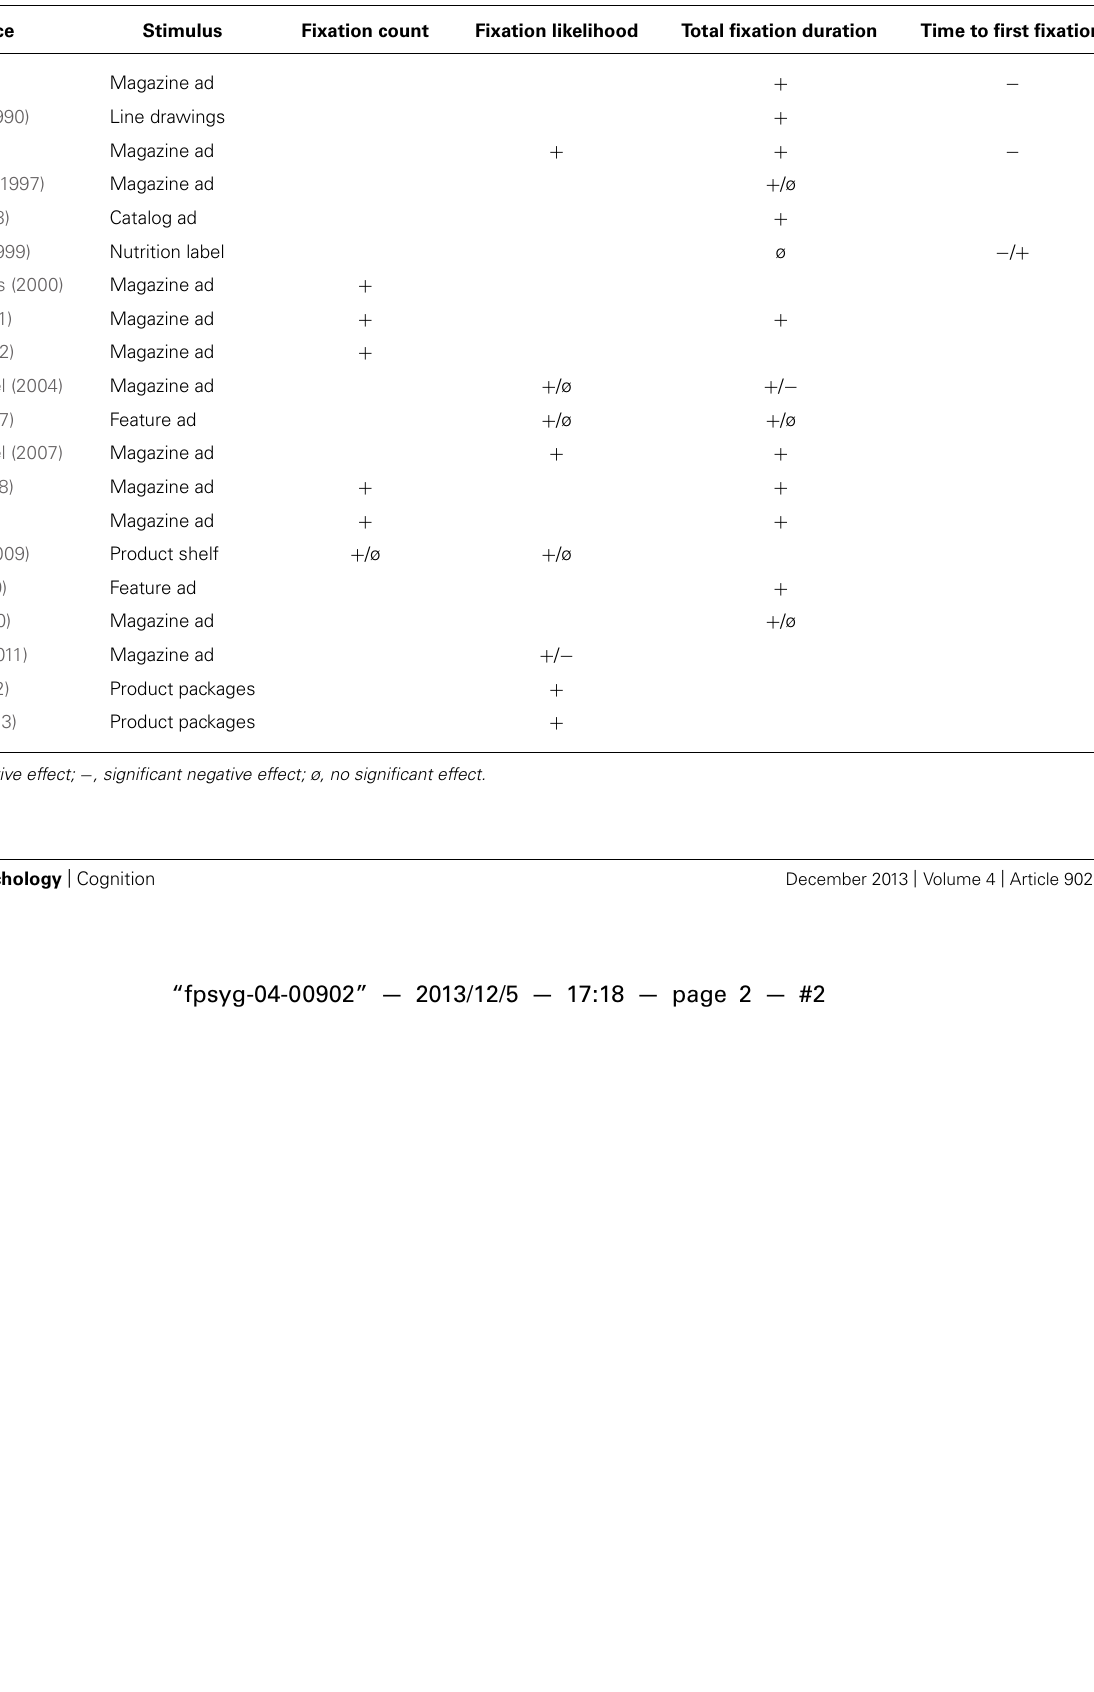
Table 1 | Overview of the existing literature and